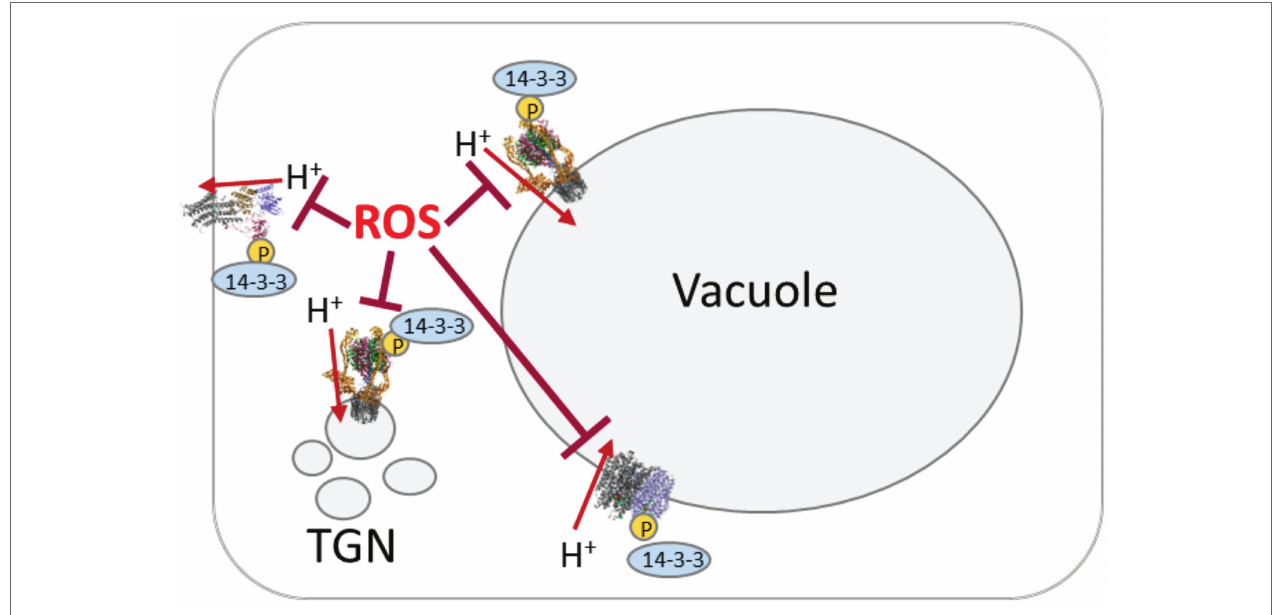
FIGURE 2 | Scheme of proton pumping-coordination by reactive oxygen species (ROS) and phosphorylation/14-3-3 proteins. Proton pumps are target of oxidative inhibition by ROS. The activated state involves phosphorylation by cytosolic kinases (“P” in yellow circle) and subsequent binding of 14-3-3